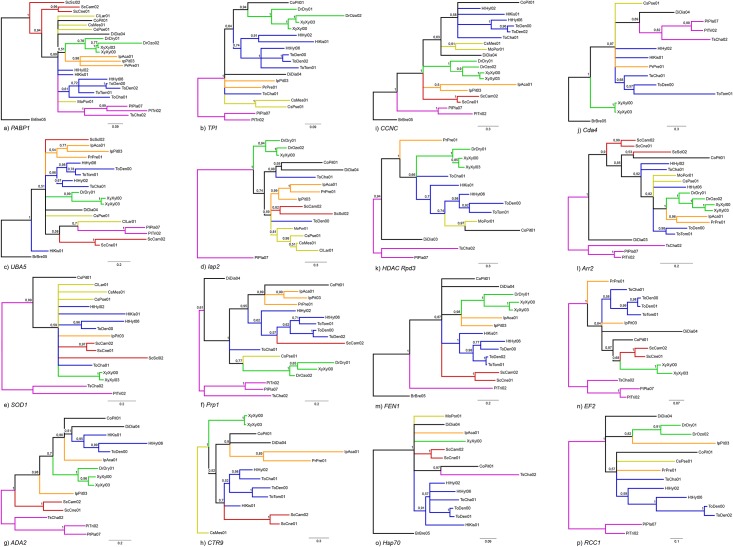
Phylogenetic trees based on Bayesian analyses of 16 selected genes.Trees were rooted with the most distant outgroup available for each marker. Posterior probabilities are given to the left of the nodes. Sequences of D. ponderosae (ToDen00) were obtained from GenBank.